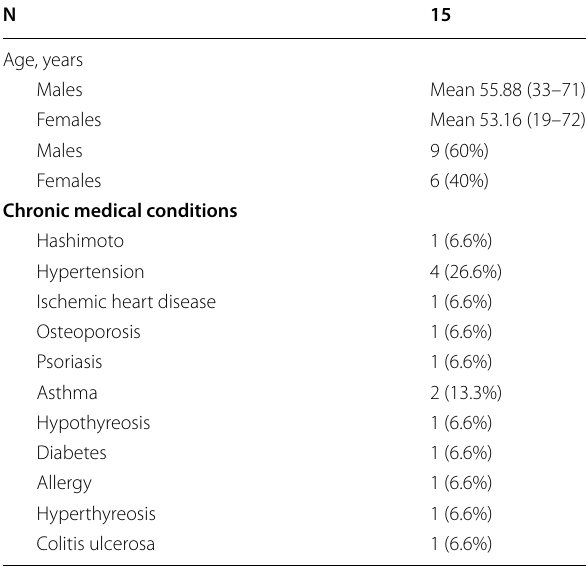
Table 1 Baseline characteristics of the